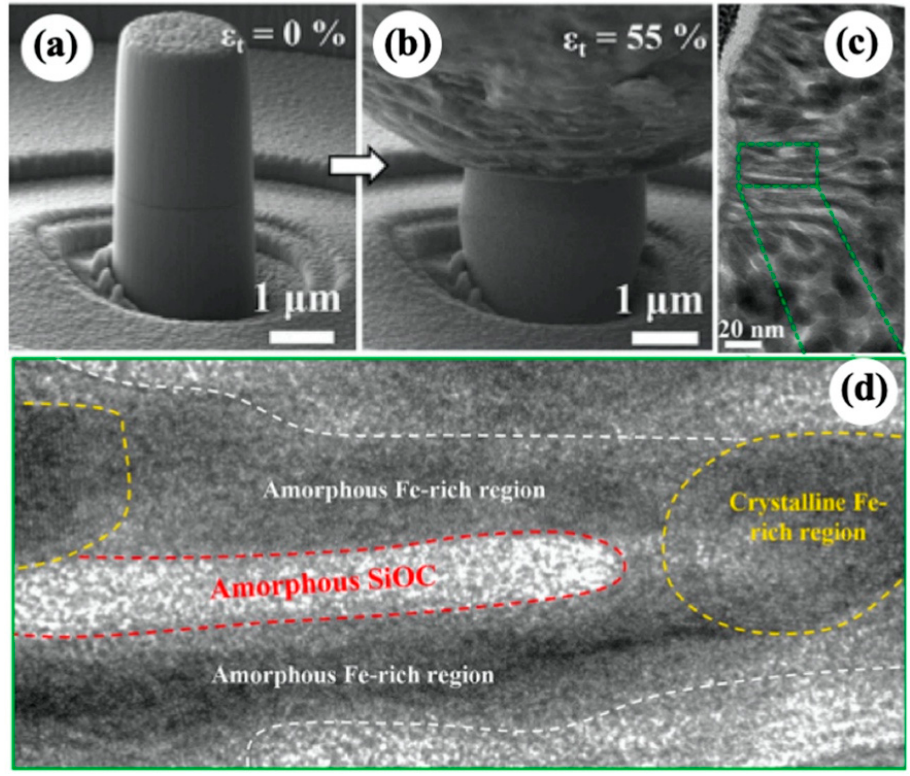
Figure 12. SEM images of Fe(34 at.%)-SiOC micropillar ( a ) before compression and ( b ) after compression test. ( c , d ) Cross-sectional TEM images showing co-deformation between Fe nanocrystals and amorphous SiOC matrix [63].